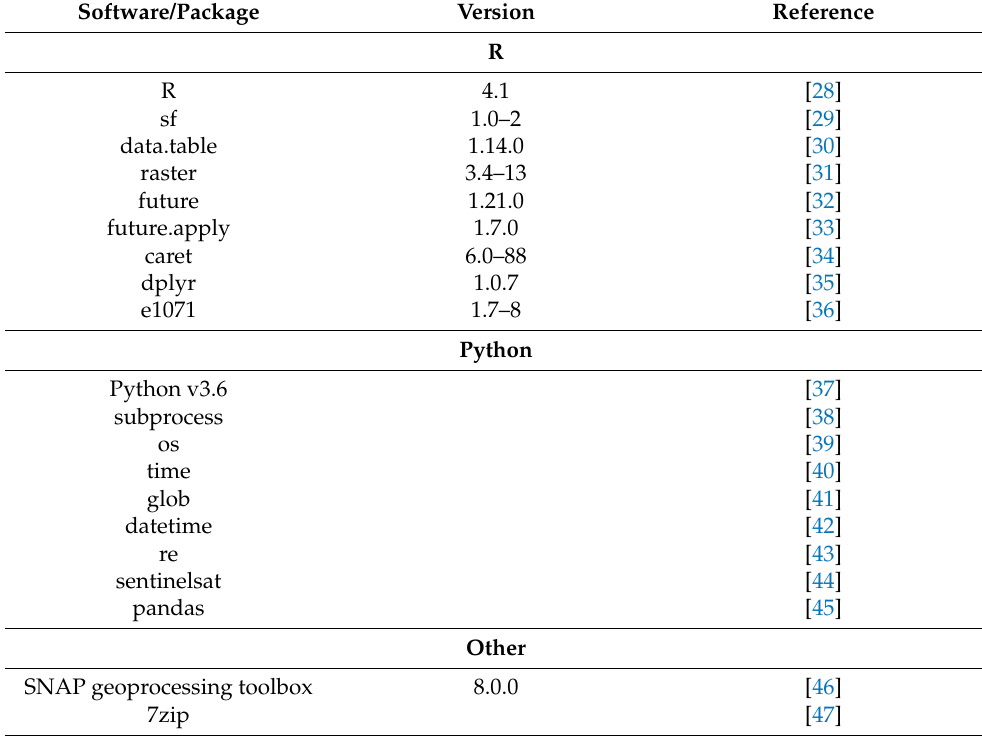
Table 1. List of software and package